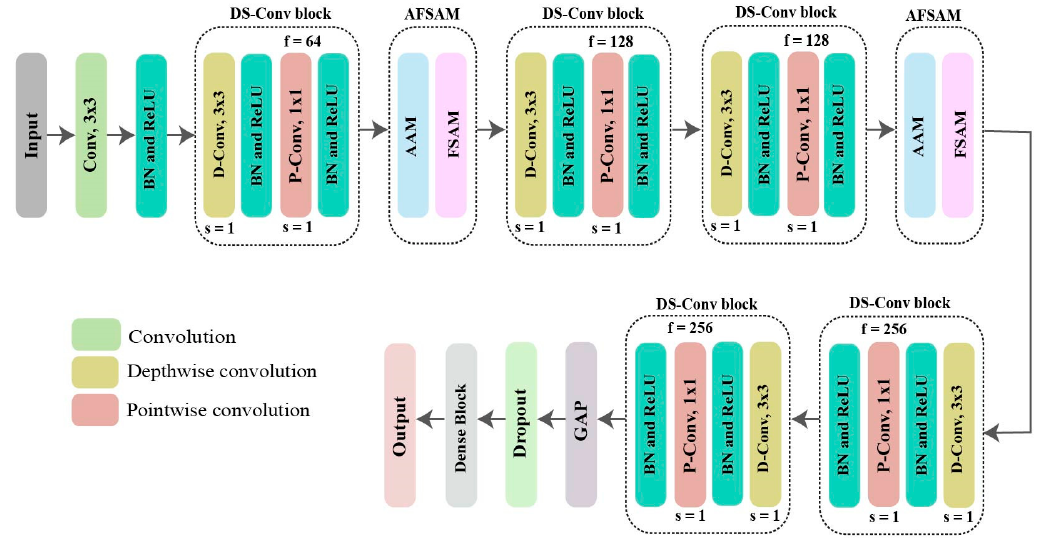
Figure 3. The architecture of our proposed model (HHI-AttentionNet).